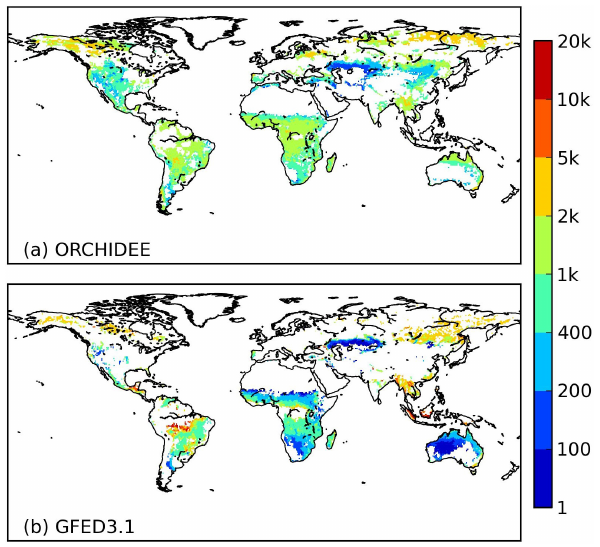
Figure 6. Mean annual carbon emissions (g C m − 2 ) for 1997–2009 by (a) ORCHIDEE simulation and (b) the GFED3.1 data, based on the whole grid cell area that included both burned and unburned